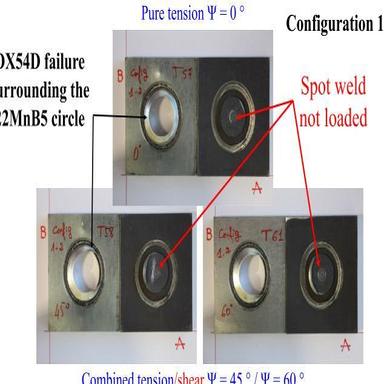
Failure modes for the pure opening test (ψ = 0∘ ) and for mixed I/II modes (ψ = 45∘ and ψ = 60∘ ) in configuration "1-2".